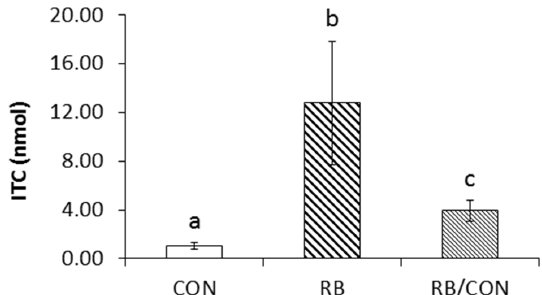
Figure 6. Reversibility of the impact of dietary broccoli on microbial GRP hydrolysis. Rats were fed with the control diet (CON), a 10% raw broccoli (RB) diet, or a 10% RB diet for four days, then the control diet four three days (RB/CON) ( n = 3). Concentrations of total isothiocyanate (ITC) in rat cecal microbiota after incubation ex vivo with GRP for 120 min. Results are mean ± SE. Values with similar letters are not different ( p < 0.05).